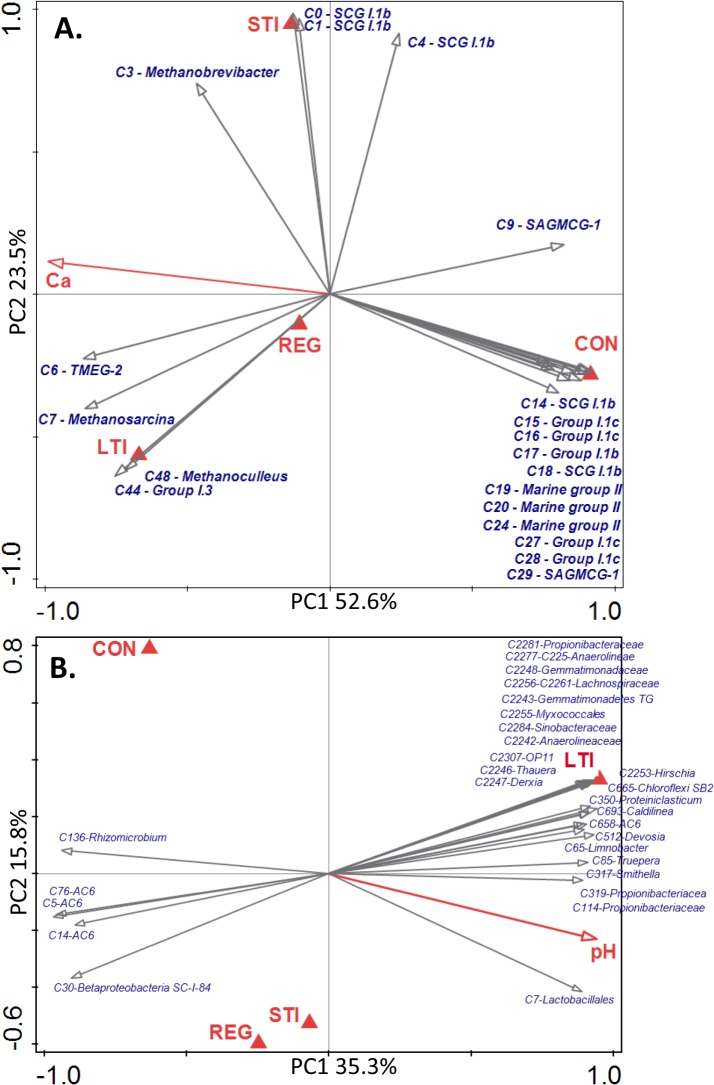
Db-RDA and two dimensional ordination plots of (A) archaeal communities and (B) bacterial communities of studied soils based on Bray-Curtis distance matrix.In (A), ordinations show the 20 best fitting archaeal OTUs are plotted together with centroids of soil samples. In (B), ordinations of the 30 best fitting bacterial OTUs are shown. Significant explanatory variables are indicated by the red arrows. The percentage of community distribution explained by each axis is indicated in the figures. (TIF)